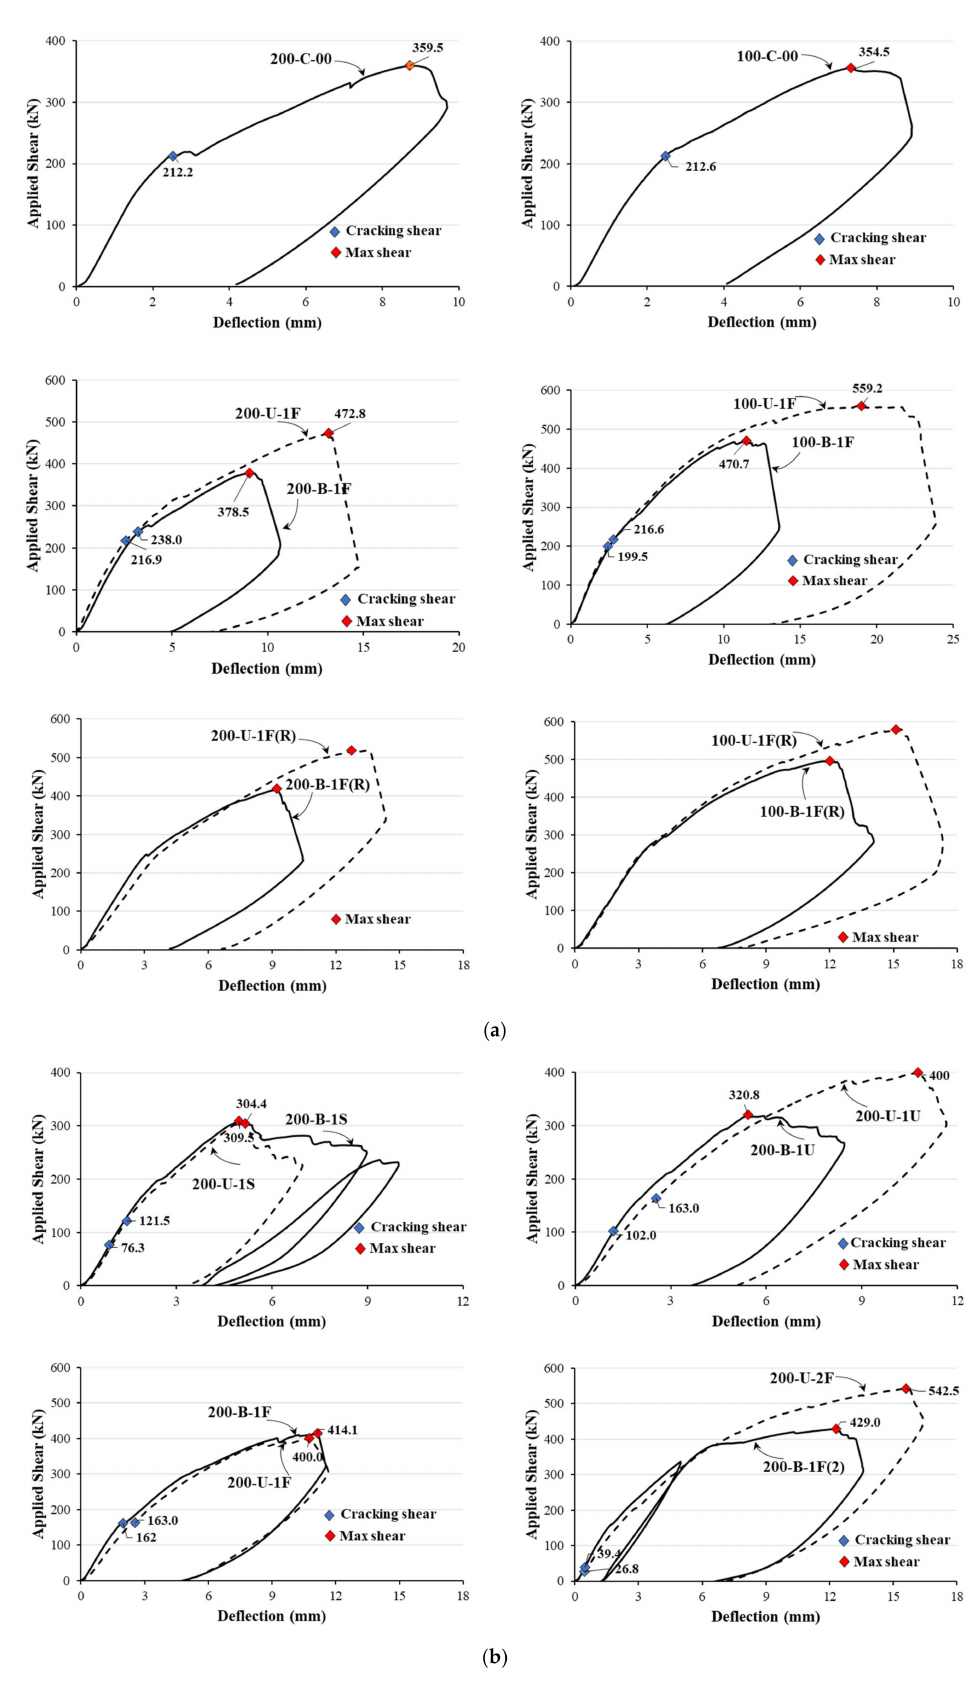
Figure 6. Load vs. deflection behavior of test specimens: ( a ) first series of specimens; ( b ) second series of